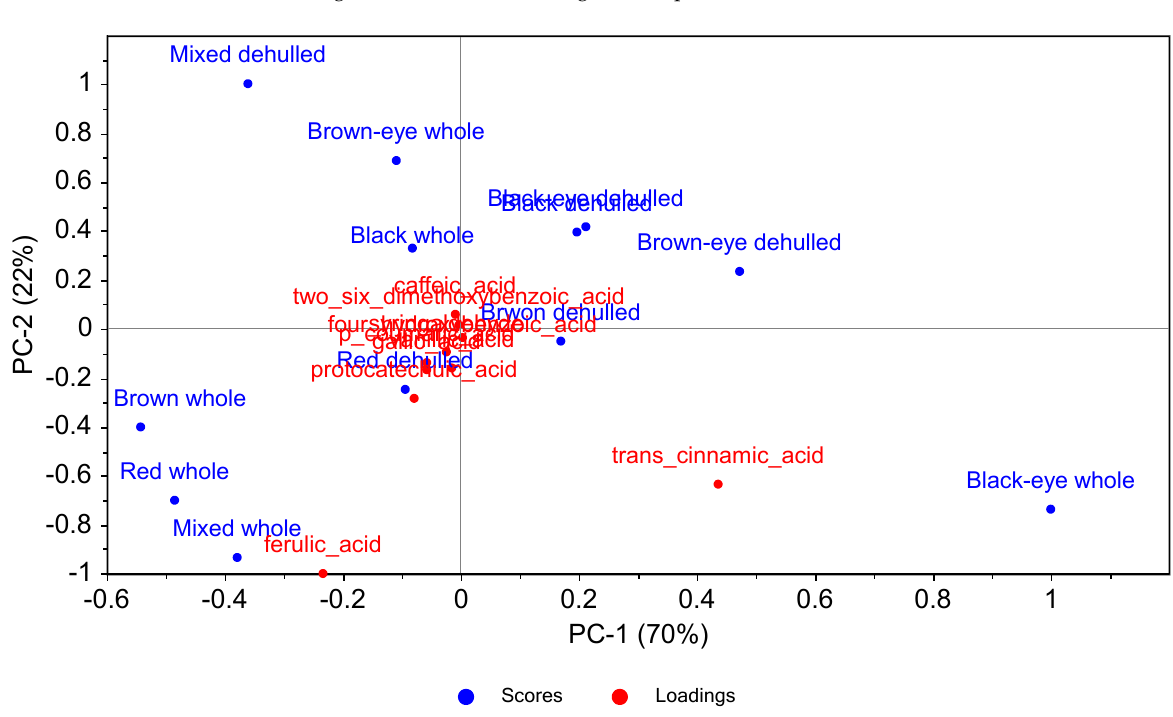
Figure 2. Principal component scores and loadings based on Bambara groundnut form and variety with regard to phenolic acid composition.